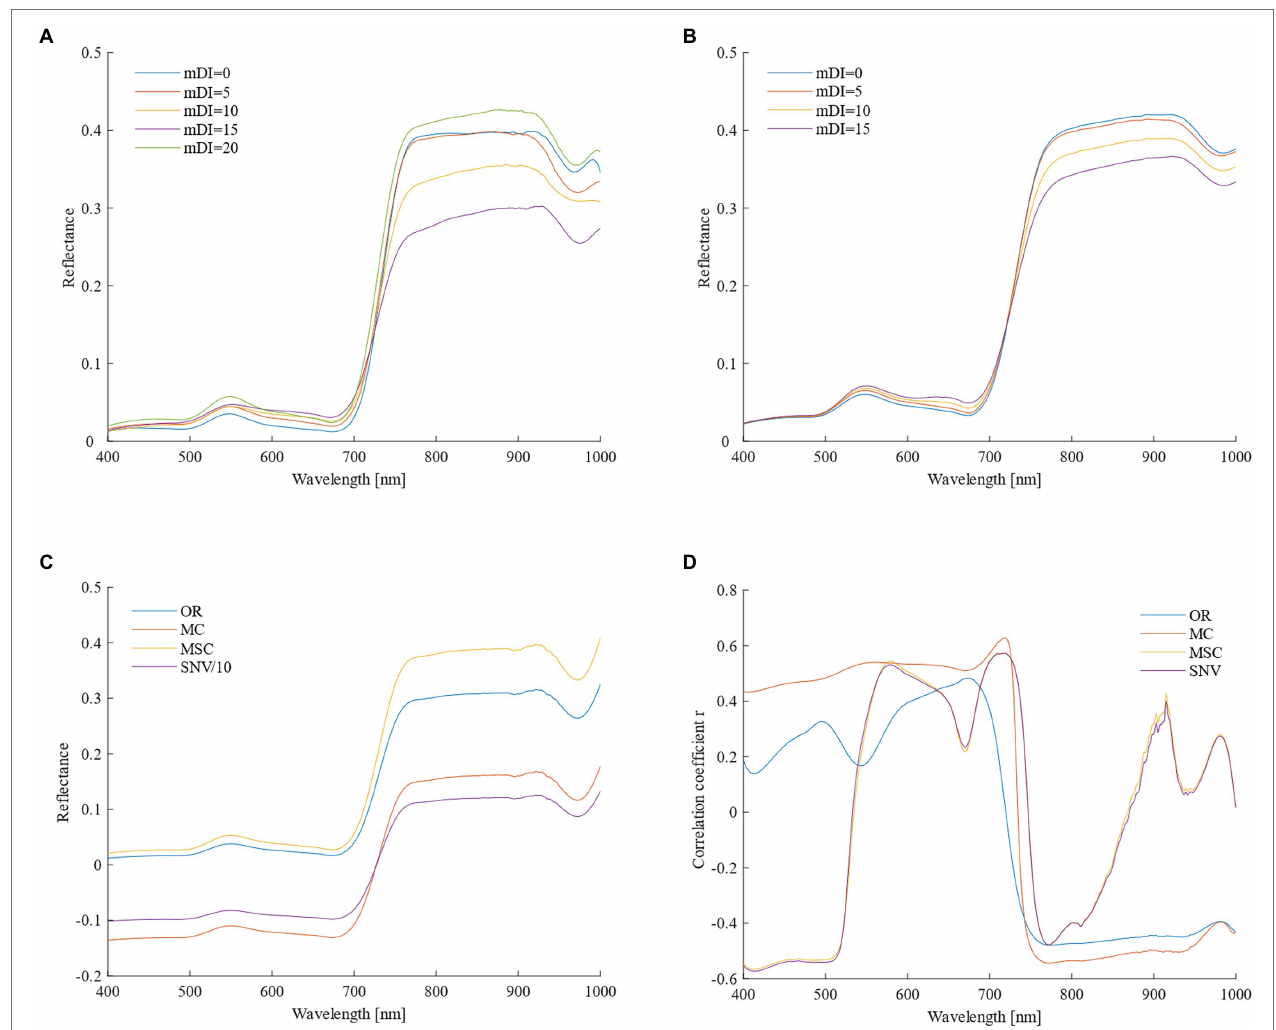
FIGURE 2 | Changes in spectral reflectance of the wheat canopy and correlation with the powdery mildew disease index ( A,B , Original reflectance of different disease severities in the high-sensitivity and medium-sensitivity types; C , spectral reflectance from the four different pretreatment methods; and D , correlation coefficients between spectral data and disease